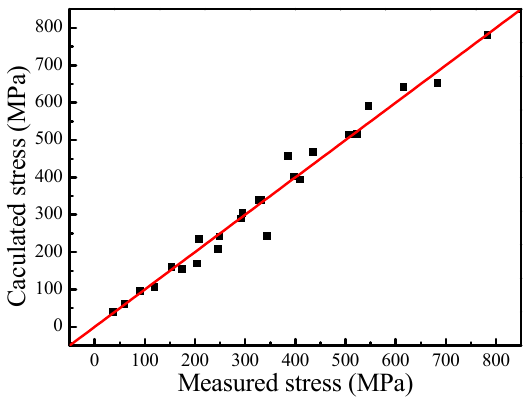
Figure 6. The comparison of the calculated and the measured peak stress.